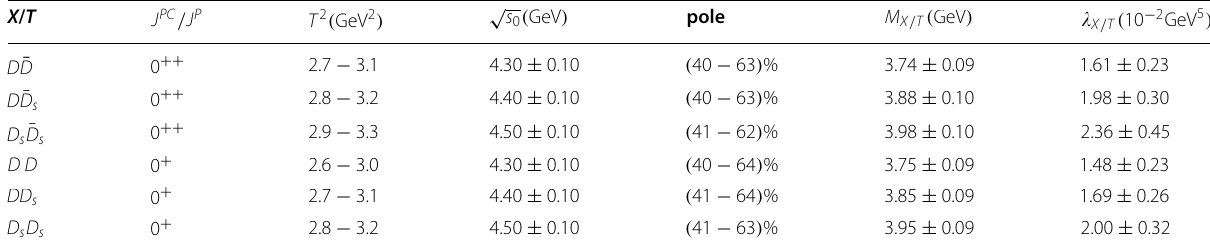
Table 1 The Borel parameters, continuum threshold parameters, pole contributions, masses, and pole residues of the molecular states X / T J PC / J P T 2 ( GeV 2 )